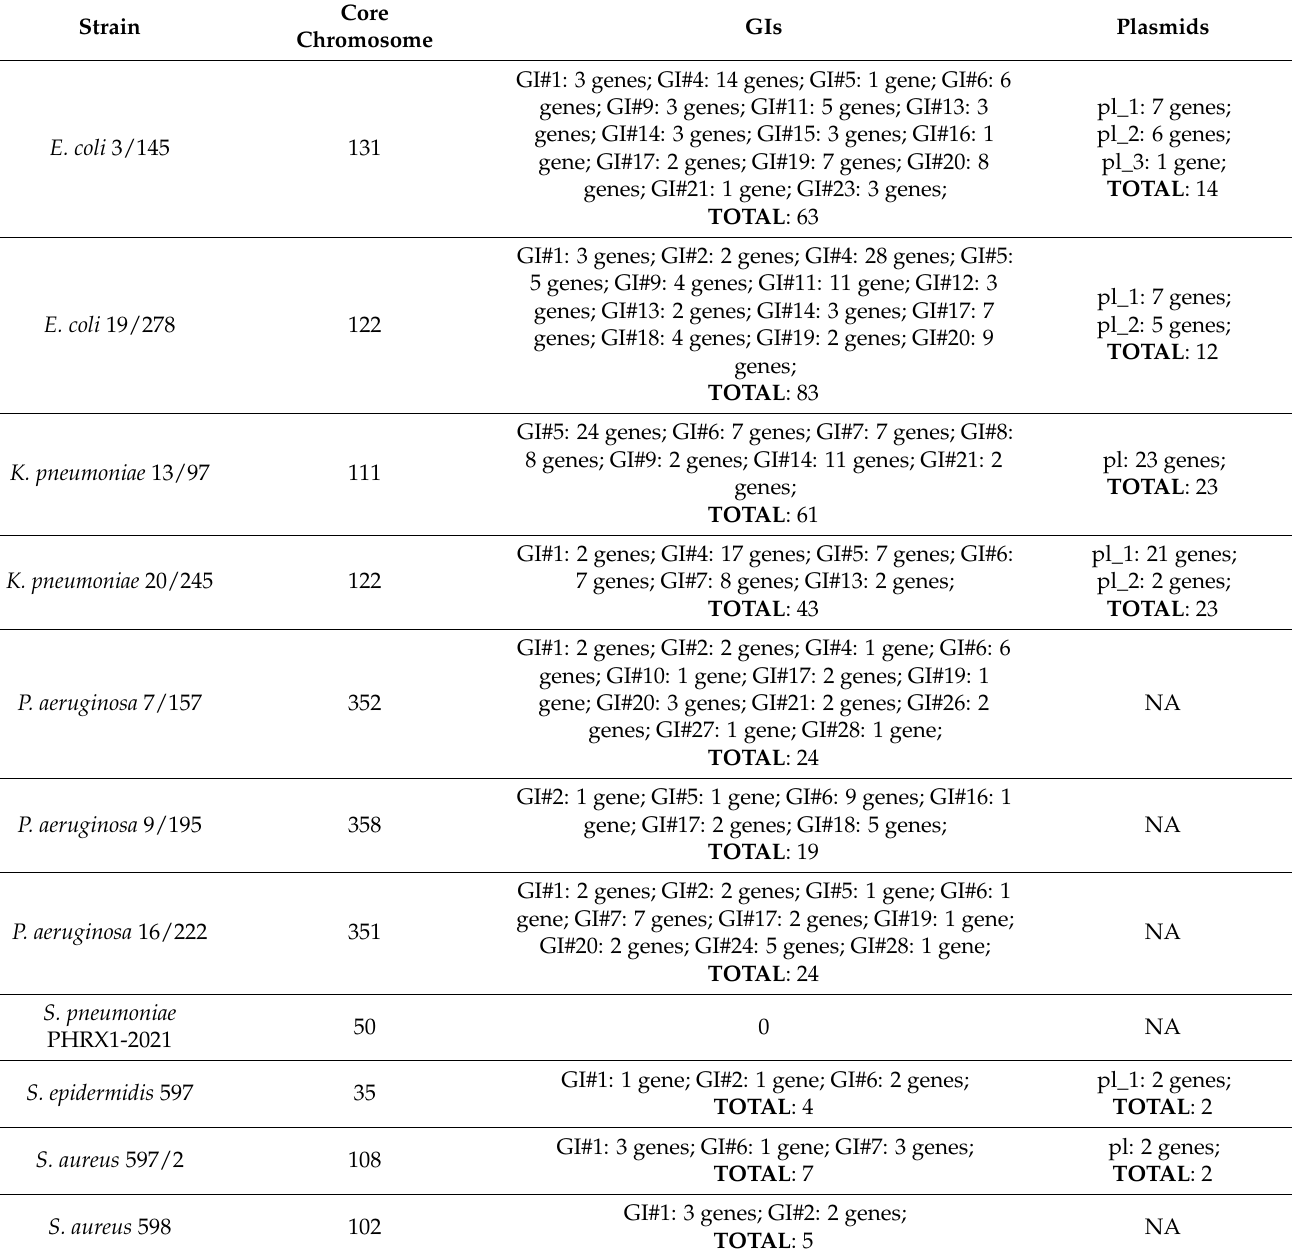
Table 4. Number of virulence factors identified in the core parts of the chromosomes, in GIs and on the